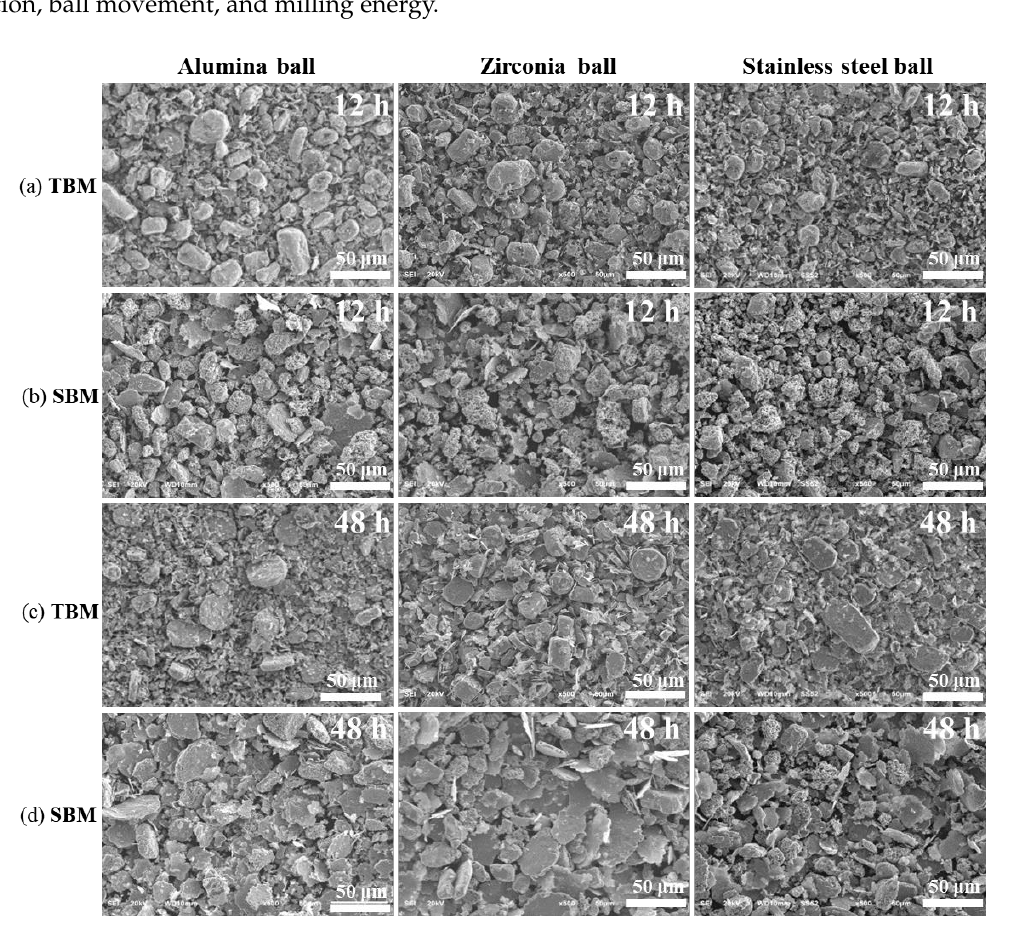
Figure 3. SEM images showing morphologies of Cu / CNT nanocomposites during exposure to di ff erent milling media ( a ) 12 h TBM, ( b ) 12 h SBM, ( c ) 48 h TBM, and ( d ) 48 h SBM at 50